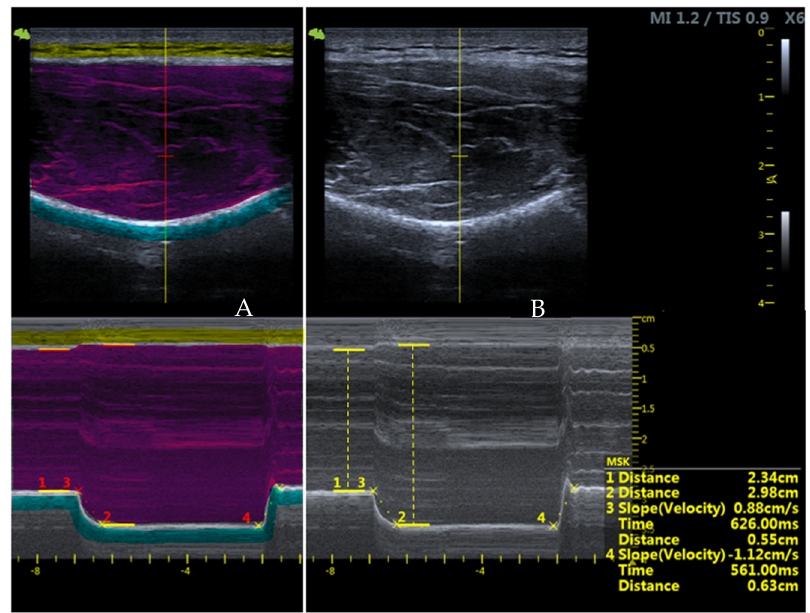
Figure 3. Infraspinatus muscle visualisation using the B-mode at the optimal point for measuring (at the top) and M-mode at the bottom. ( A ) Highlighted the fat tissue (yellow), infraspinatus muscle (red) and bone (blue). ( B ) 1: thickness at rest; 2: thickness at contraction; 3: activation velocity; 4: relaxation velocity.